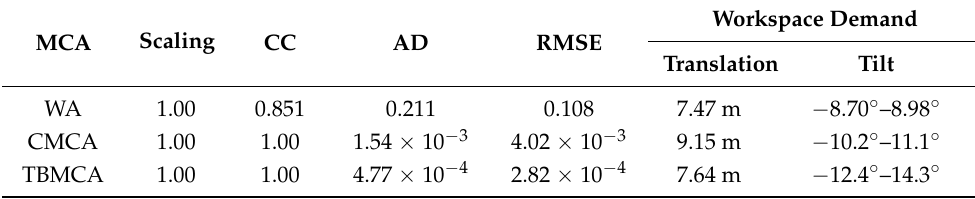
Table 3. Comparison of the MCAs for the WLTC driving cycle.